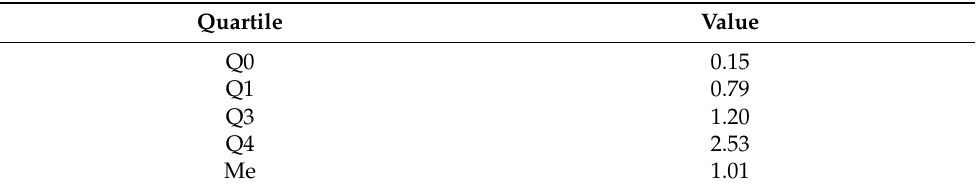
Table 3. Quartiles border values.